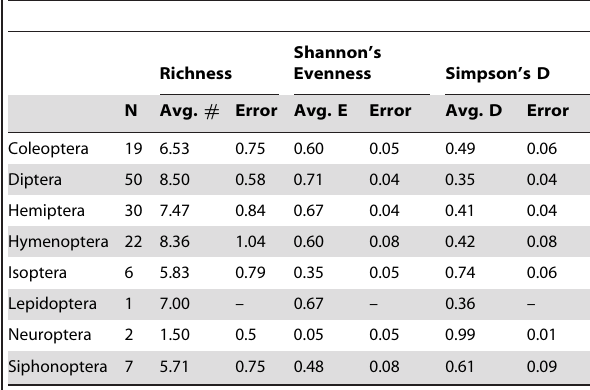
Table 2. Richness and evenness of bacterial communities for eight insect orders.